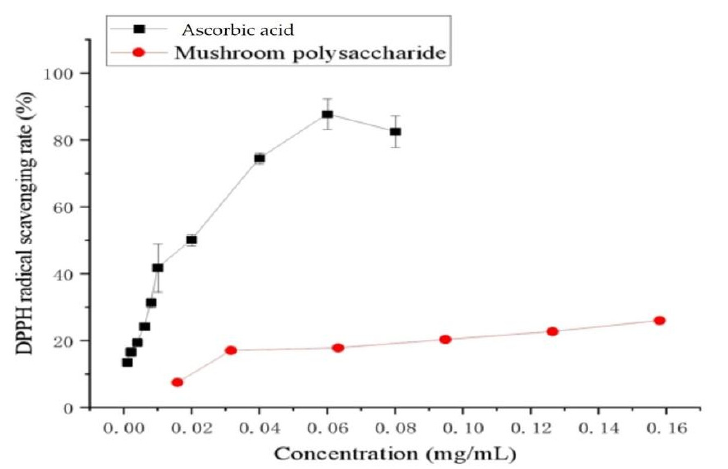
Figure 4. In vitro antioxidant activity assessment DPPH radical scavenging activity of polysaccharide from chestnut mushroom. Values are expressed as mean ± SD ( n = 3).